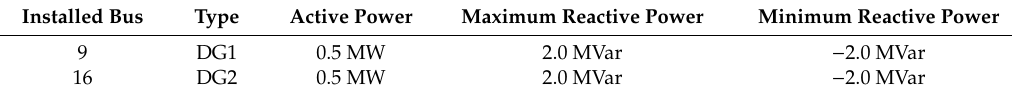
Table 1. Parameters of DGs for case 1.